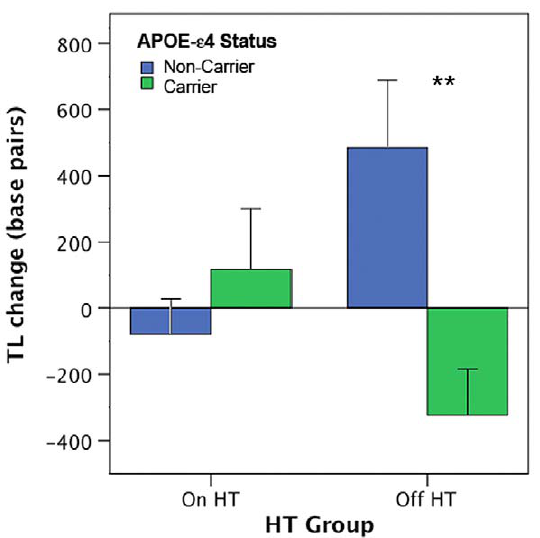
Figure 2. Impact of hormone therapy on telomere dynamics is APOE-dependent. Initial evidence that the impact of the APOE- e 4 risk allele on cell aging is modulated by HT use in mid-life women. Among women who were randomized to stay on HT (n=26) for the two year study period, no significant difference in TL attrition was detected between e 4-carriers and non-carriers. Among women who went off HT (n=16), those carrying the risk allele exhibited telomere shortening, while non-carriers exhibited telomere maintenance/growth. Values represent mean TL change (base pairs) adjusted for study covariates. Error bars represent S.E.M, ** p # .005.